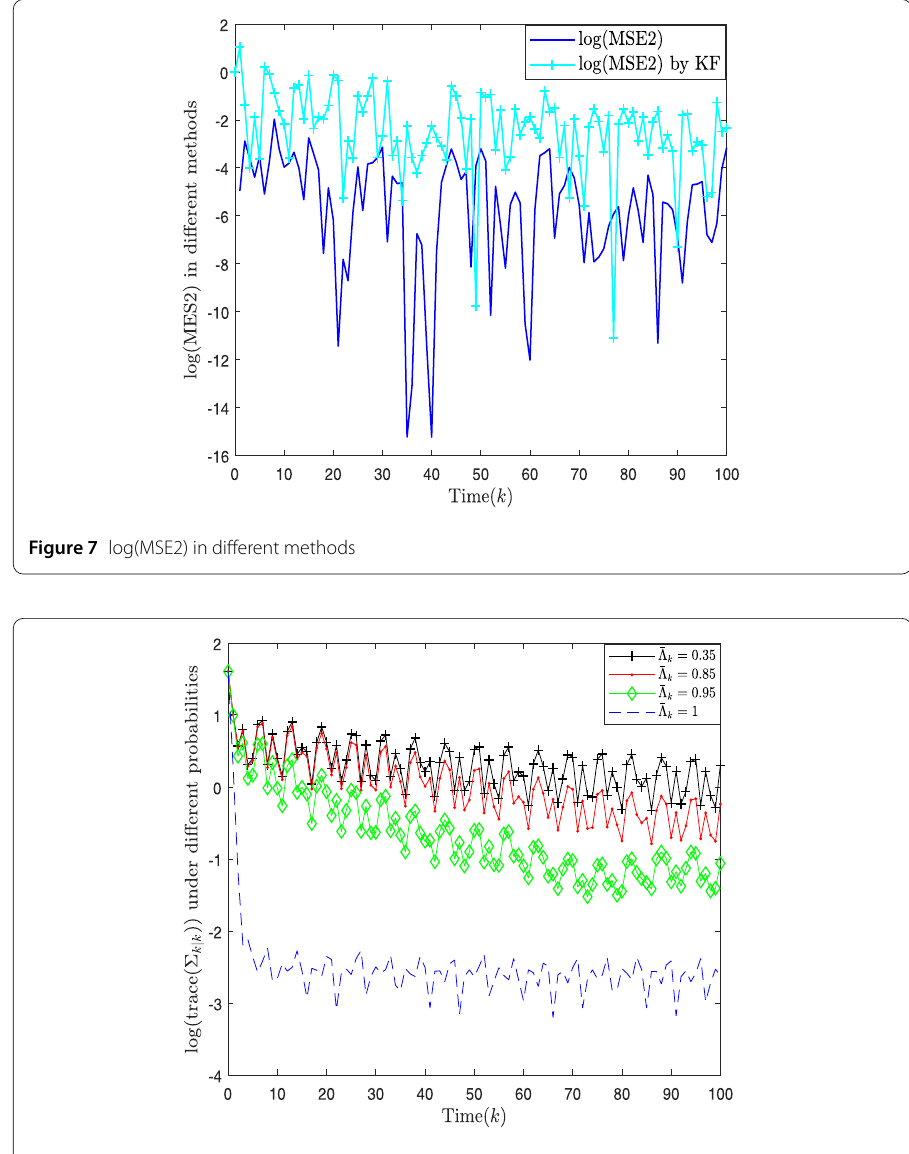
Figure 8 log(trace( Σ k | k )) under different occurrence